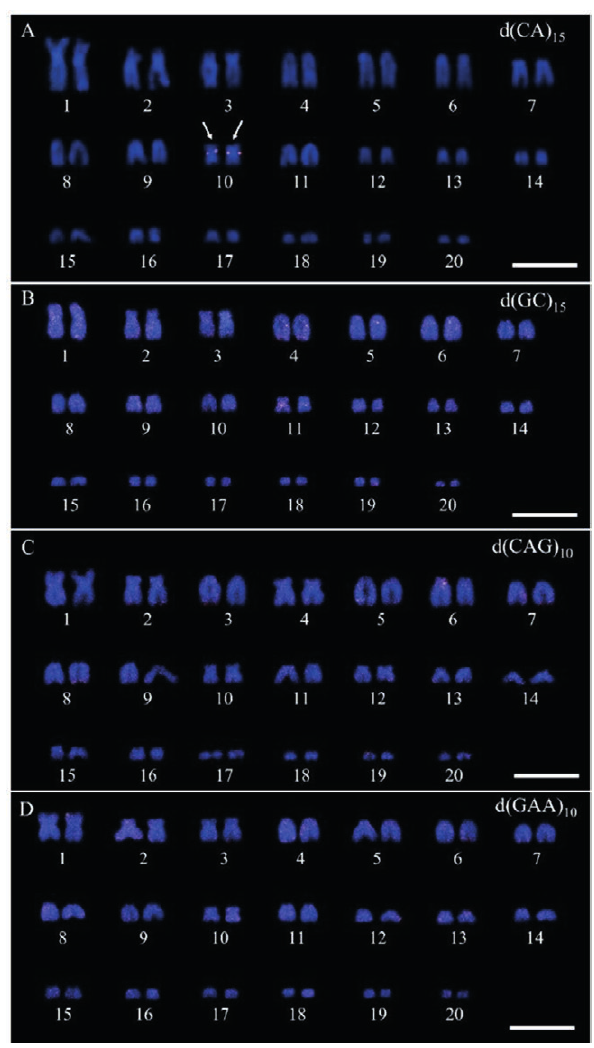
Figure 4. Karyotypes of Cyrtodactylus inthanon , 2 n =40 present- ing the patterns of microsatellite d(CA) 15 , d(CAG) 10 , d(GAA) 10 and d(GC) 15 (A-D). Scale bars: 5